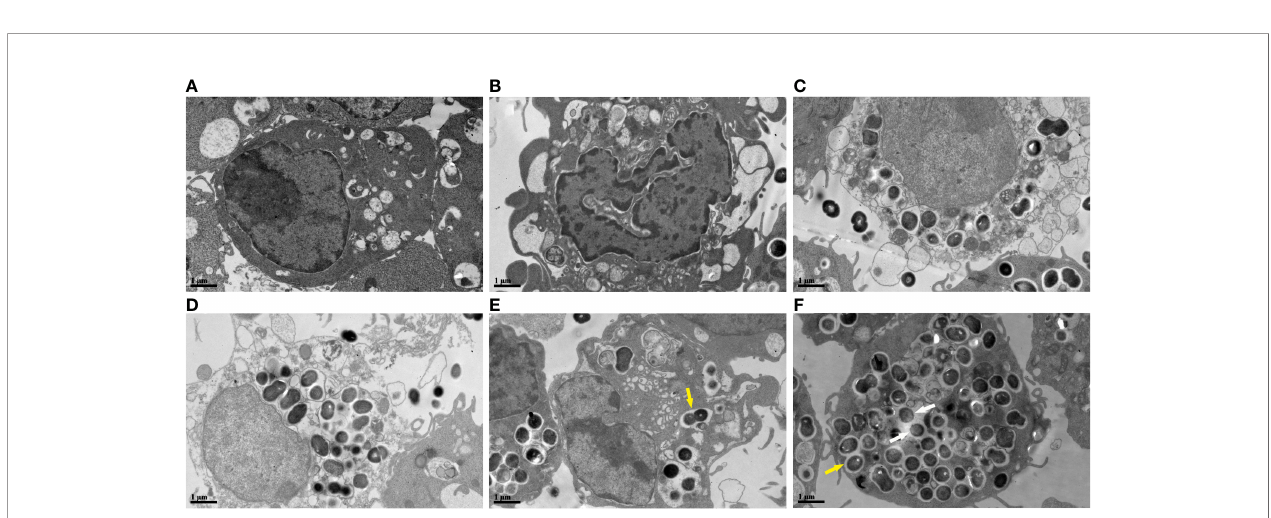
FIGURE 5 | Ultrastructural changes of RAW264.7 cells infected with E. faecalis OG1RF under TEM (A) Control RAW264.7 cells showing an intact cell membrane. (B) Cellular ultrastructure of apoptotic-like changes: cell shrinkage. (C) Cellular ultrastructure of pyroptotic-like changes: swollen cells with incomplete cell membrane. (D) Cellular ultrastructure of necroptotic-like changes: swollen cells with ruptured cell membrane. (E) Engulfed E. faecalis in monolayer membrane vesicles 6 h post- infection. (F) Some escaped E. faecalis cells outside of membrane vesicles. The yellow arrow indicates E. faecalis surrounded by monolayer membrane vesicles, and the white arrow represents escaped E. faecalis cells outside of membrane vesicles. Scale bar: 1 m